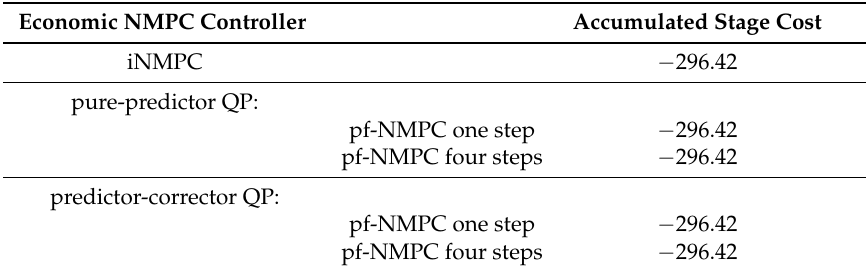
Table 4. Comparison of economic NMPC controllers (no noise). Accumulated stage cost in $.